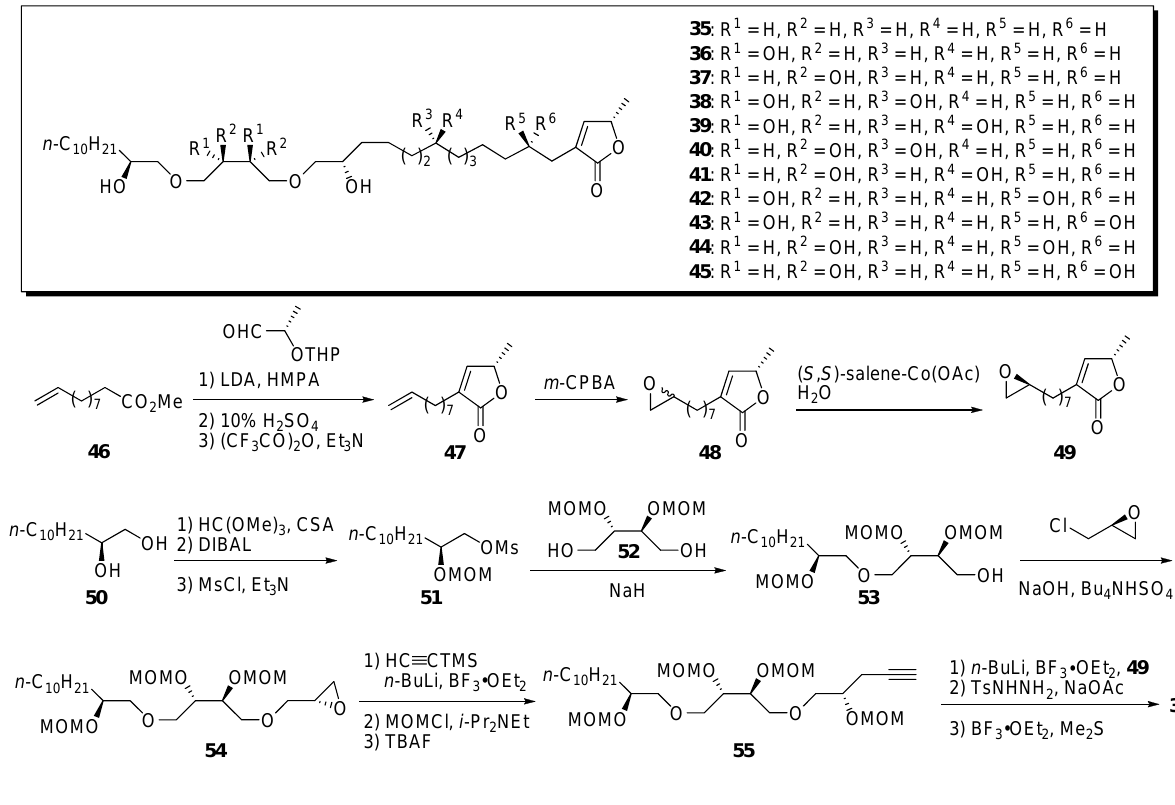
Table 4. Cytotoxicity against human solid tumor cell